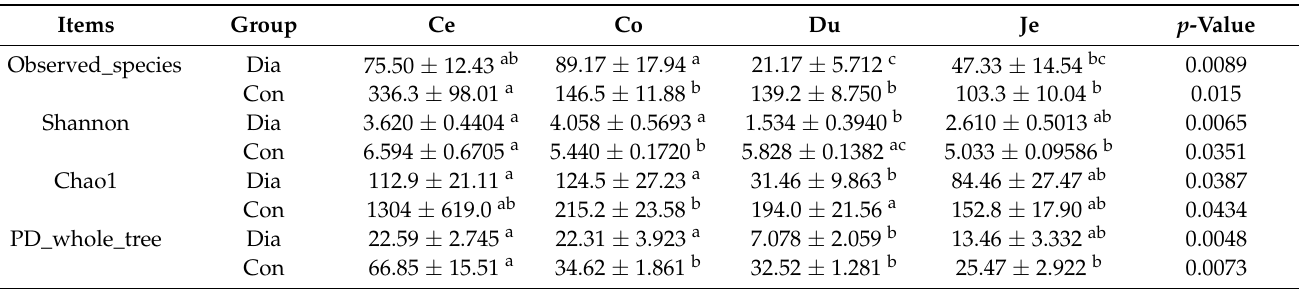
Table 1. The alpha diversity indexes of bacterial communities in the FIS of Hyplus